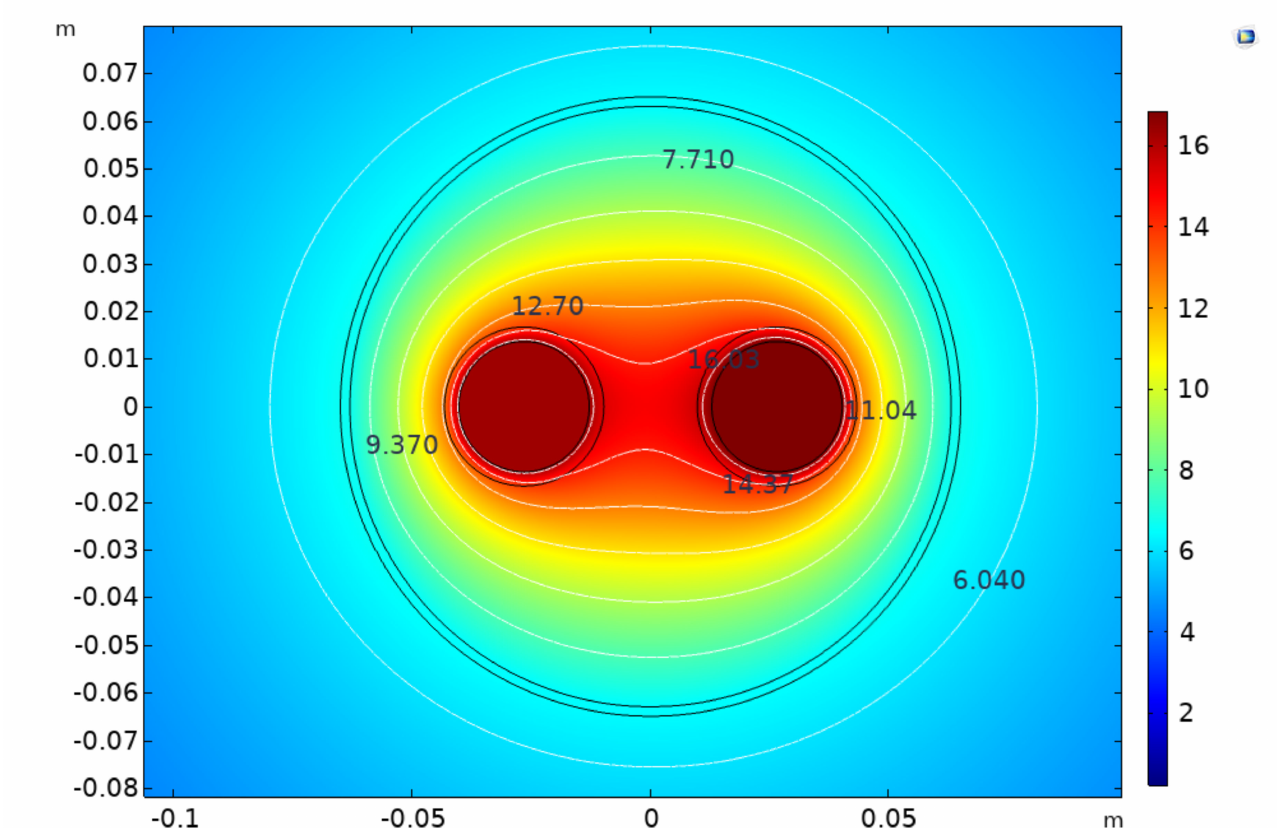
Figure 11. Color map of the temperature-rise distribution in the BHE and in the close surrounding sand at the final instant of time, in ◦ C, for k g = 0.863 W/(mK), ( ρ c ) g = 4.6 MJ/(m 3 K), k s = 3.22 W/(mK), and ( ρ c ) s = 3.0667 MJ/(m 3